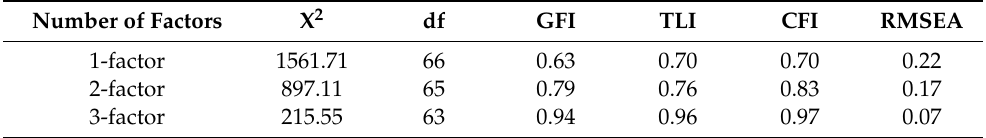
Table 5. Testing of the Mediation Model ( N = 466). Table 4. Results of the Confirmatory Factor Analysis.